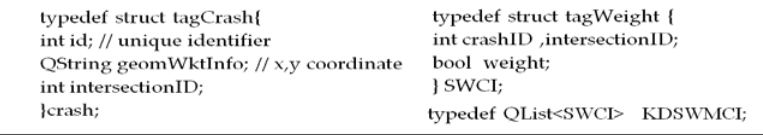
Figure 4. Definition of the main data types of the KDSWMCI generation algorithm.